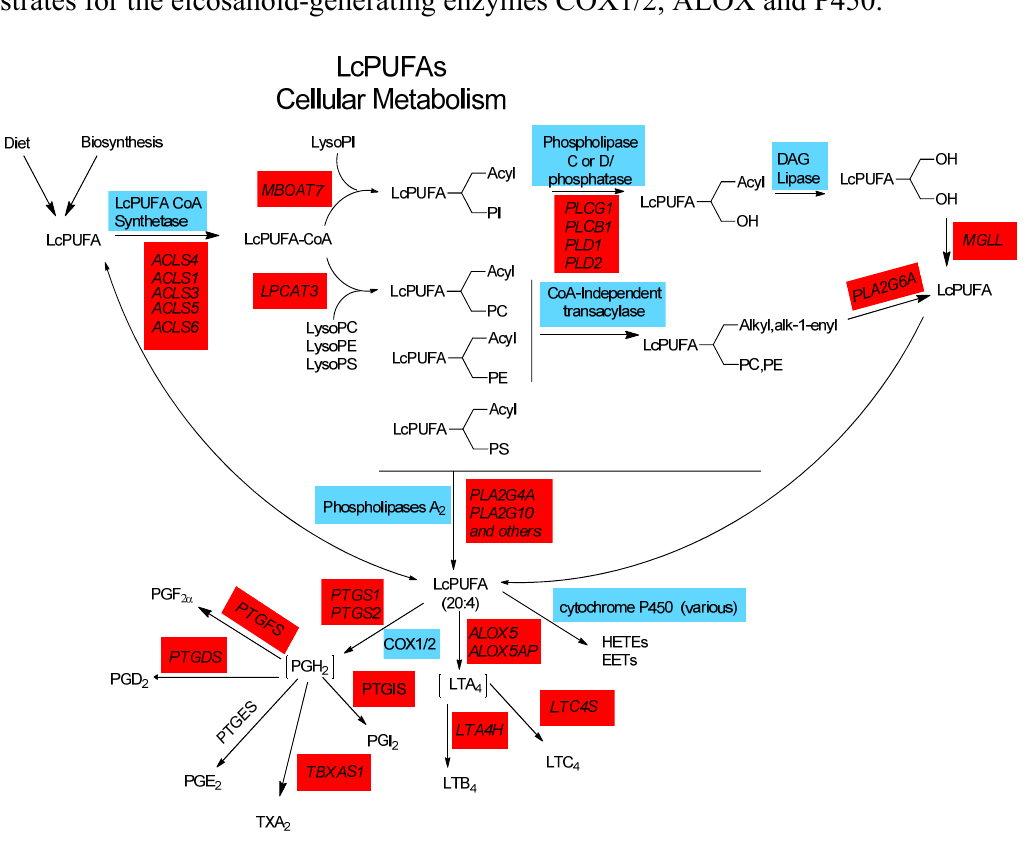
Figure 2. LCPUFA Cellular Metabolism. The incorporation of LCPUFAs into phospholipids and their release occur by a complex network of enzymatic activities and related